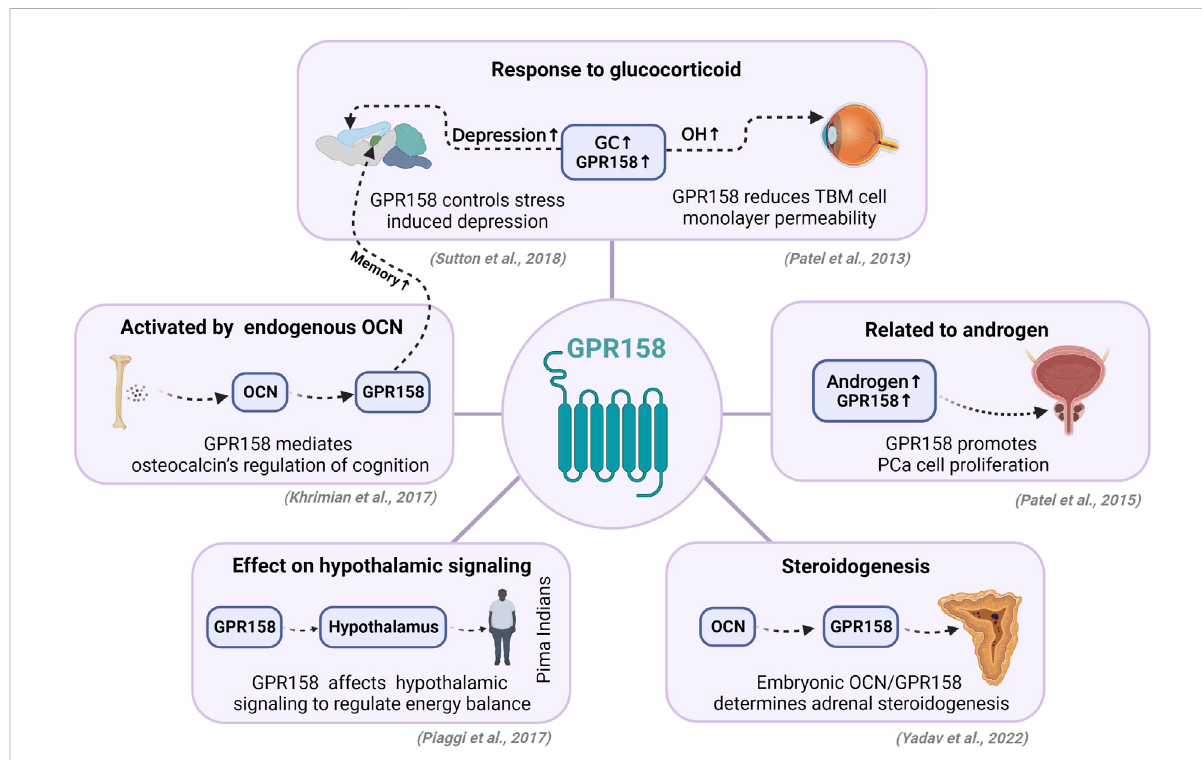
FIGURE 1 Endocrine-related functions of GPR158. GPR158 is abundantly expressed in the nervous system and participates in the pathogenesis of depression, glaucoma, etc. ,butsomestudies indicatethatGPR158 isrelatedto endocrinepathways.Inthenervoussystem,GCisdirectlyinvolvedin GPR158-mediated depression and alterations in intraocular pressure. The peripheral bone-derived hormone OCN can affect cognitive functions via GPR158. Moreover, a study in Pima Indians con fi rmed that GPR158 regulates energy balance by affecting hypothalamic signaling. In peripheral tissues, GPR158 is also closely associated with androgen and androgen receptors, thereby regulating the proliferation of prostate cancer cells. Interestingly, therelatively high expression of GPR158 intheadrenal gland candirectly affectthegenerationof adrenocorticosteroids throughOCN. GC, glucocorticoid; OH, ocular hypertension; TBM, trabecular meshwork; OCN, osteocalcin; PCa, prostate cancer. The fi gure was created with